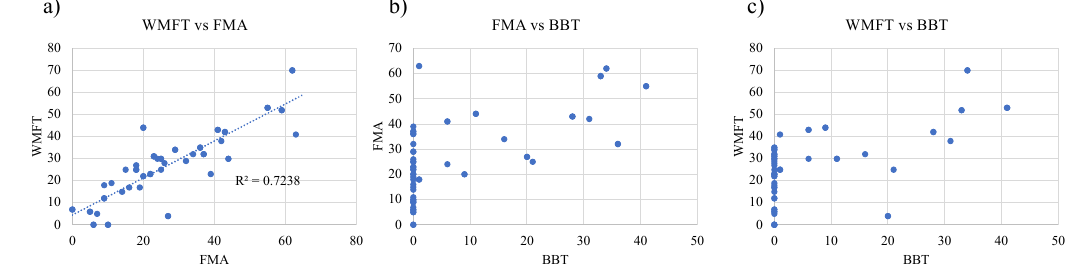
Figure 6. The sensitivity of outcome measures to UE motor function. Comparisons of sensitivity were made among FMA, WMFT and BBT as ( a ) WMFT vs. FMA, ( b ) FAM vs. BBT, ( c ) WMFT vs. BBT. Note that FMA has almost the same sensitivity to severe UE motor function as WMFT, and that of FMA has a close association with WMFT, while BBT is less sensitive than FMA and WMFT.